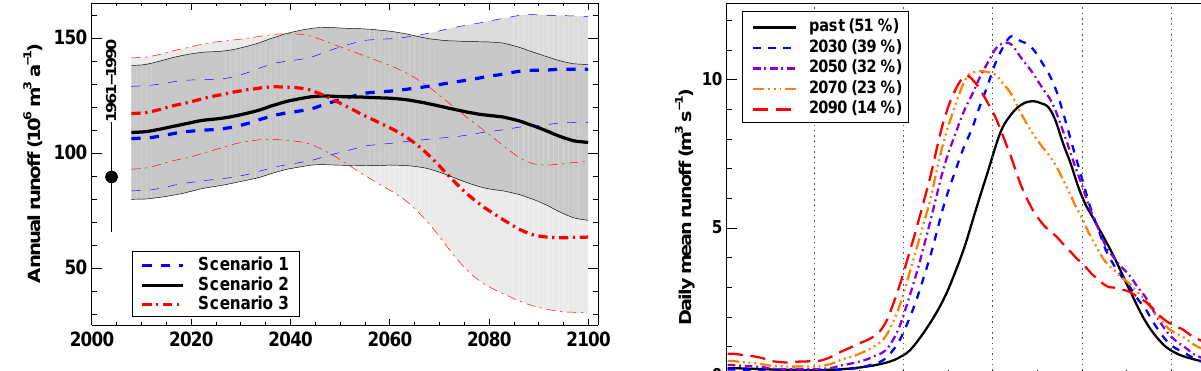
Fig. 12. Calculated annual runoff volume from the Rhonegletscher catchment based on three climate scenarios. Shaded areas indicate the range of variability ( ± 2 standard deviations σ ) obtained by performing multiple model runs with random meteorological variability around the expected average of each scenario (solid lines). The dot shows the measured mean annual runoff in the climatic normal period, ± 2 σ are indicated.